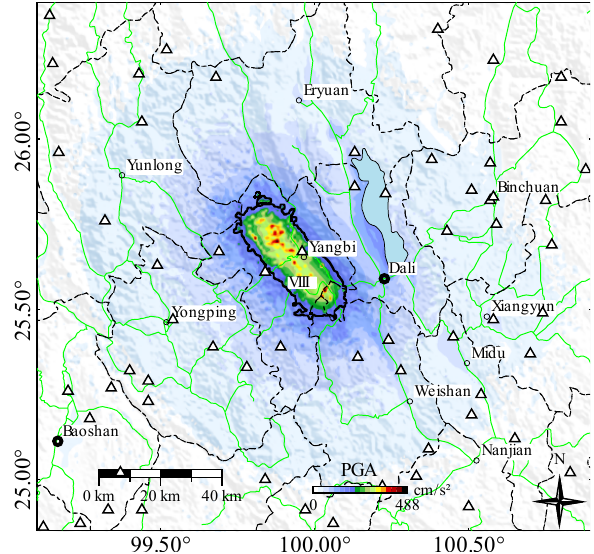
Figure 8. Spatial distribution of the simulated PGA. The black line delineates the area of seismic intensity VIII. White triangles are the strong motion stations deployed around the epicentral area.